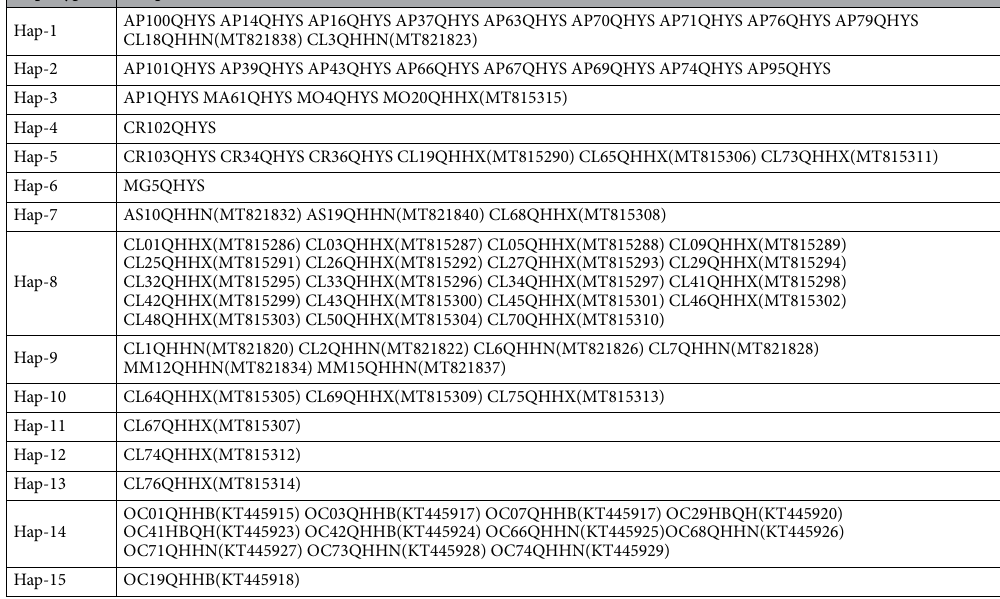
Table 4. Haplotypes of B. grahamii strains. AP Apodemus peninsulae , AS Apodemus speciosus, CL Cricetulus longicaudatus, CR Cricetidae , MA Microtus arvalis , MG Microtus gregalis , MO Microtus oeconomus , MM Mus musculus, OC Ochotona curzoniae . QH Qinghai Province, HB Haibei, HN Huangnan, HX Haixi, YS